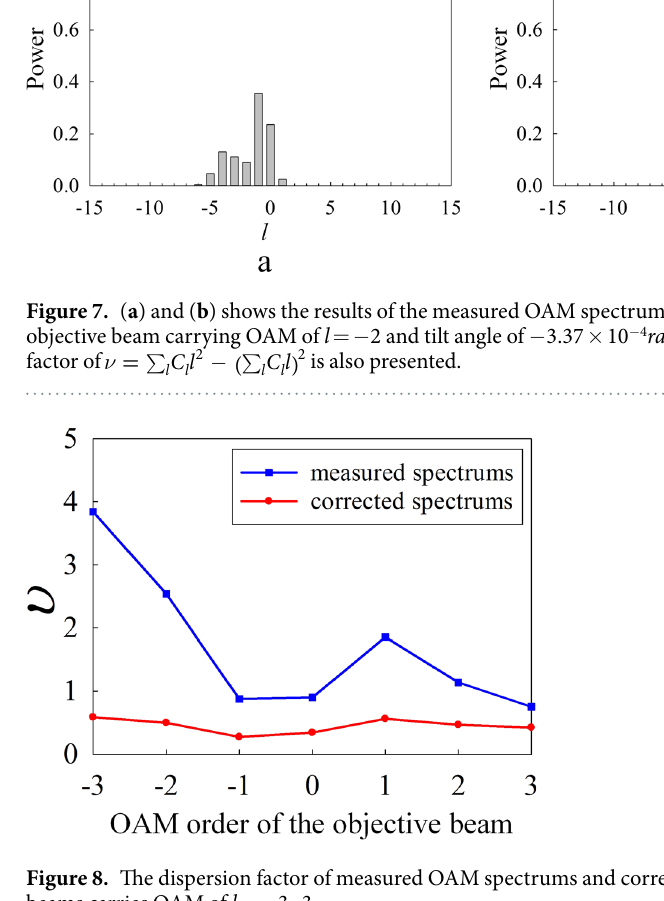
Figure 8. The dispersion factor of measured OAM spectrums and corrected OAM spectrums. The objective beams carries OAM of l = −